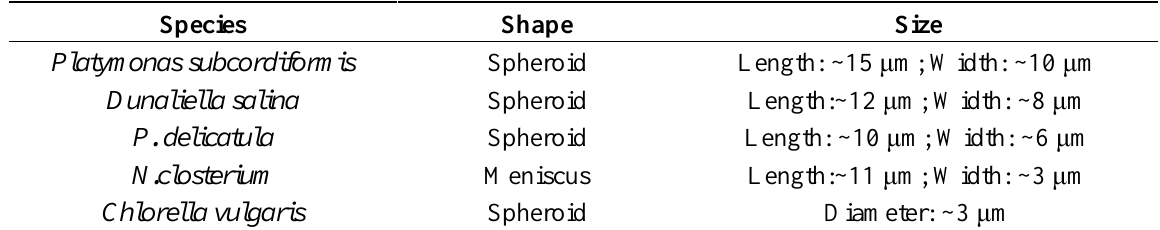
Table 2. The shape and size of the tested microalgal